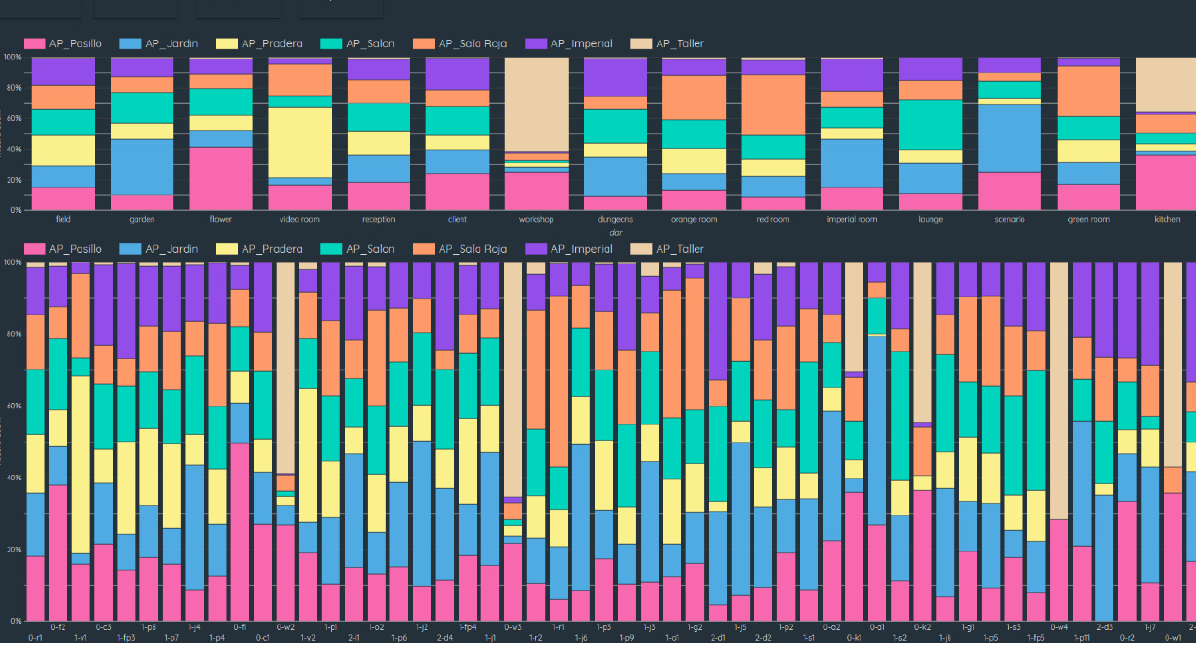
Figure 9. Access points and record count from each space (digital platform visualizations are shown with black background). Once the data were cleaned, they were classified and analyzed through the categories.